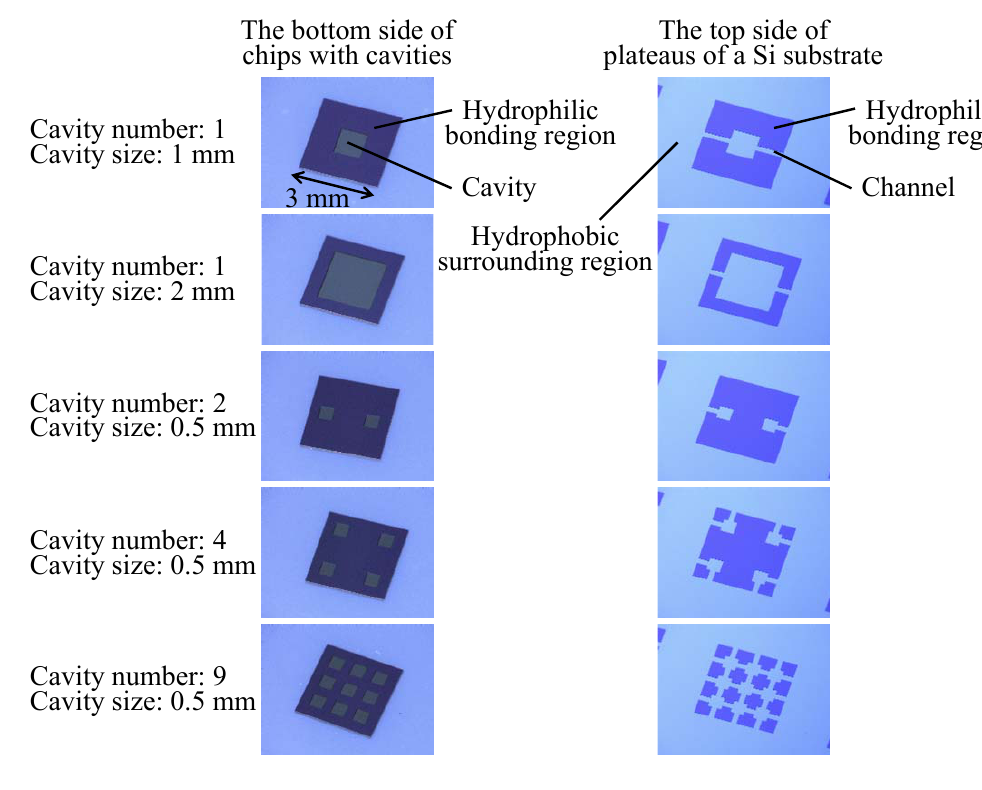
Figure 3. A cross-sectional SEM view of chips with a cavity.